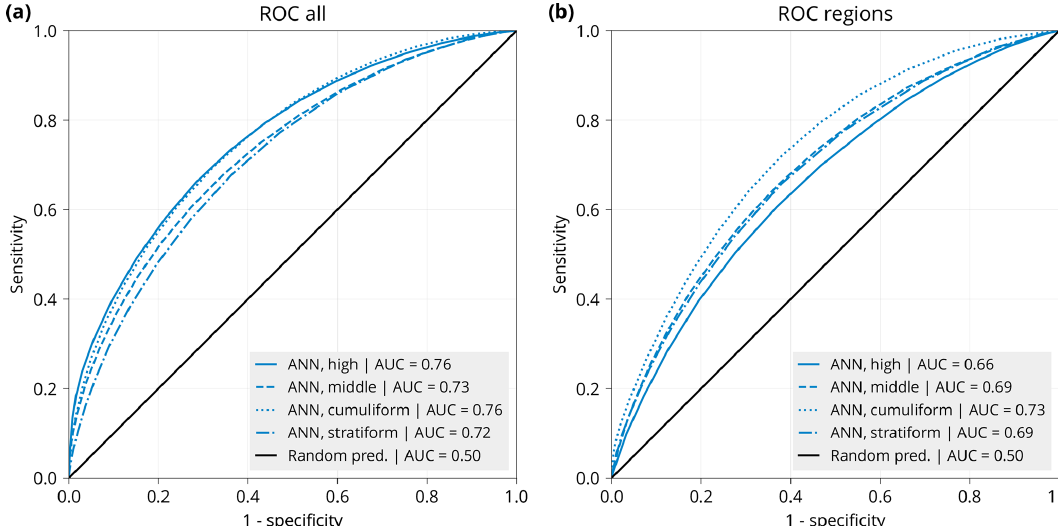
Figure 5. Receiver operating characteristic (ROC) diagram calculated for (a) an ANN for the four cloud types trained on all training years (2003–2020, except the validation years 2007, 2012 and 2017) on all data available globally, evaluated against station reports from the IDD in the validation years and (b) a composite of four ANNs trained on all training years on all data available globally except for each of the four validation regions (North Atlantic, East Asia, Oceania and South America), evaluated against station reports from the IDD in the respective region in the validation years. Shown is also the ROC of a random predictor. Sensitivity is the true positive rate (probability of a positive prediction if positive in reality), also called the hit rate. Specificity is the true negative rate (probability of a negative prediction if negative in reality). “1-specificity” is also called the false alarm rate. The area under the curve (AUC) of the ROCs is in the